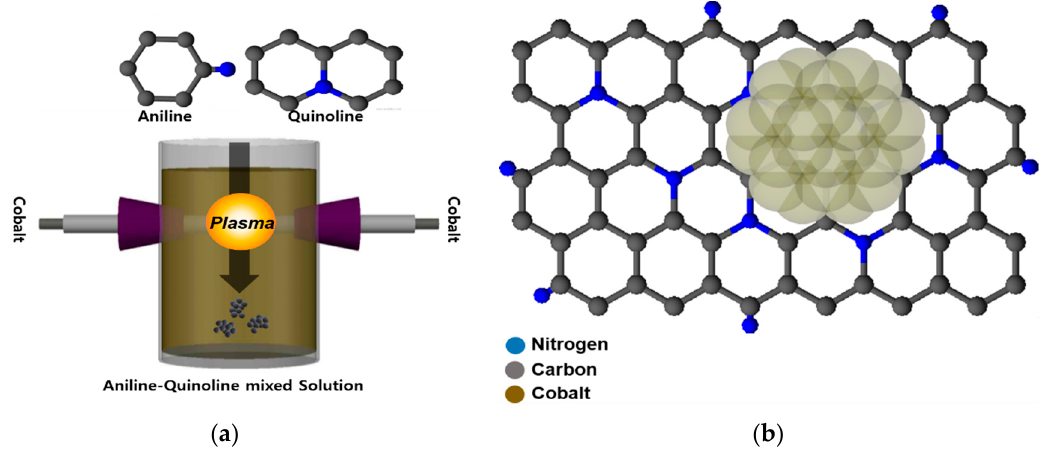
Figure 1. ( a ) Schematic illustration of the solution plasma process and synthesis of the cobalt nanoparticles/N-doped carbon (Co-N/C) catalyst. ( b ) Structure of the N-doped carbon catalyst .